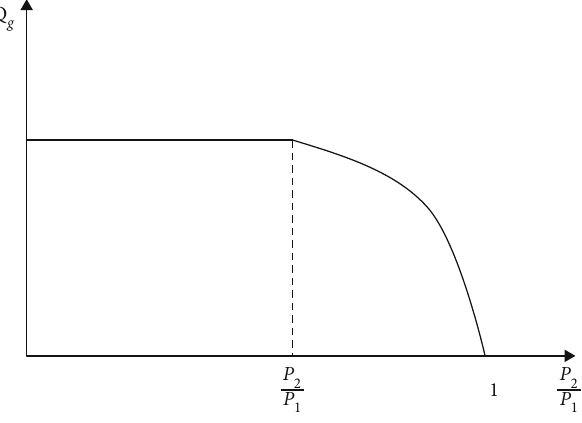
Figure 1: Flow characteristics through